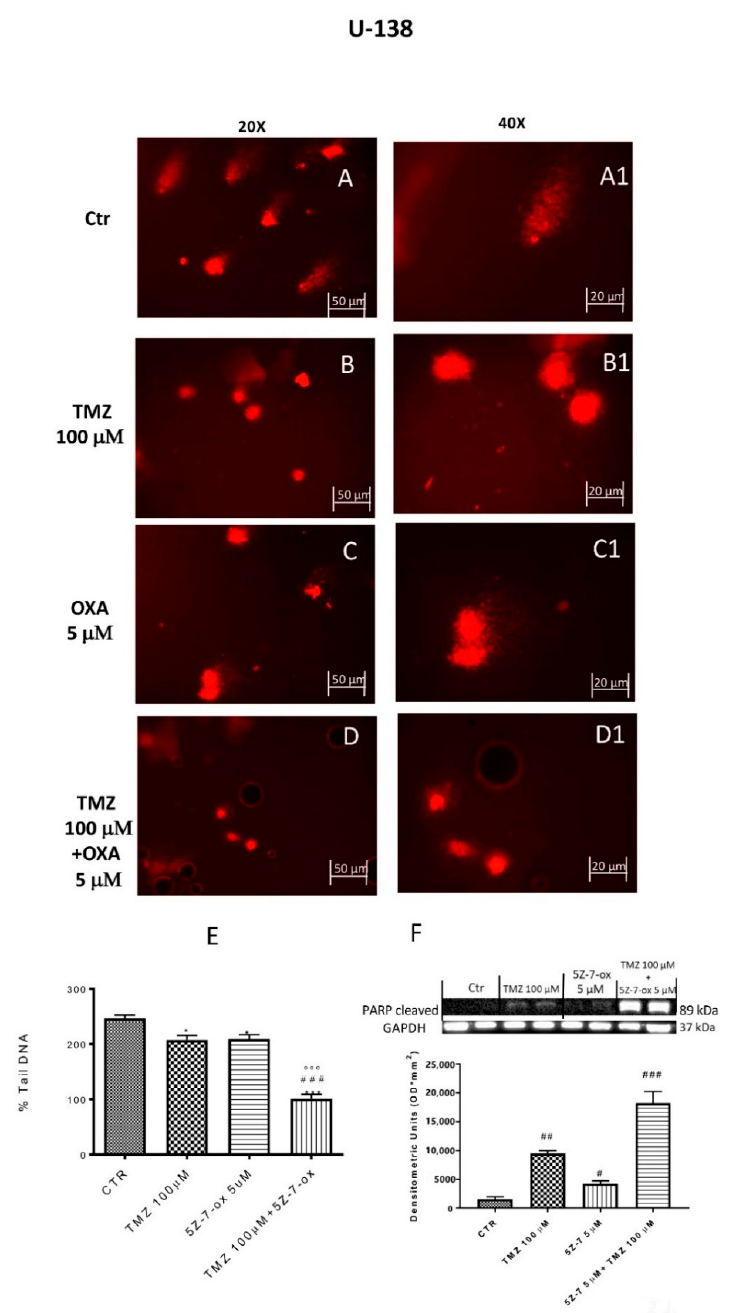
Figure 4. Effect of 5Z-7-ox and TMZ on DNA damage in U138 cell line. Alkaline comet assays (% tail DNA as comet pattern) were taken to quantify DNA damage. Panel ( A ) and densitometry in F shows the comet patterns obtained in glioblastoma control group, whereas panel ( B , C ) shows the comet pattern recorded from pre-incubation with TMZ and 5Z-7-ox showed that pre-treatment was efficacious in reducing DNA damage, however panel ( D ) demonstrates how the association significantly reduced the % of DNA tail. ( A1 – D1 ) shows the high magnification at 40×. The panel ( E ) shows the densitometry analysis of comet patterns. Data are representative of at least three independent experiments. * p < 0.05 vs. CTR, *** p < 0.001 vs. CTR, ### p < 0.001 vs. TMZ and °°° p < 0.001 vs. 5Z-7-ox. Panel F shows cleaved PARP-1 expression by Western blot analysis. A basal level of cleaved PARP in the CTR group cell lysates was observed, while the association between TMZ with 5Z-7-ox significantly up-regulated the expression of cleaved PARP-1 ( F ). Data are representative of at least three independent experiments. # p <0.05 vs. CTR, ## p <0.01 vs. CTR; ### p <0.001 vs. CTR. Original blots are shown in Figure S3.